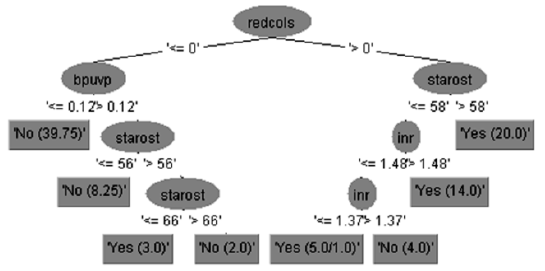
Figure 3. The decision tree with feature subsets (using 15 attributes).